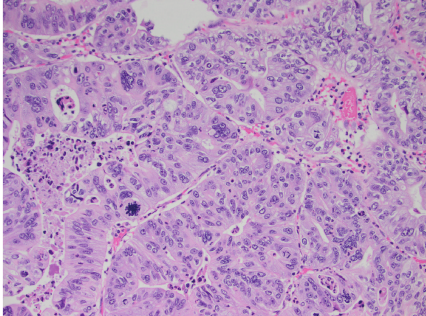
Figure 3: High power image of the tumor with multinucleated tumor cells and atypical mitotic figure. Image provided by Martine C McManus,